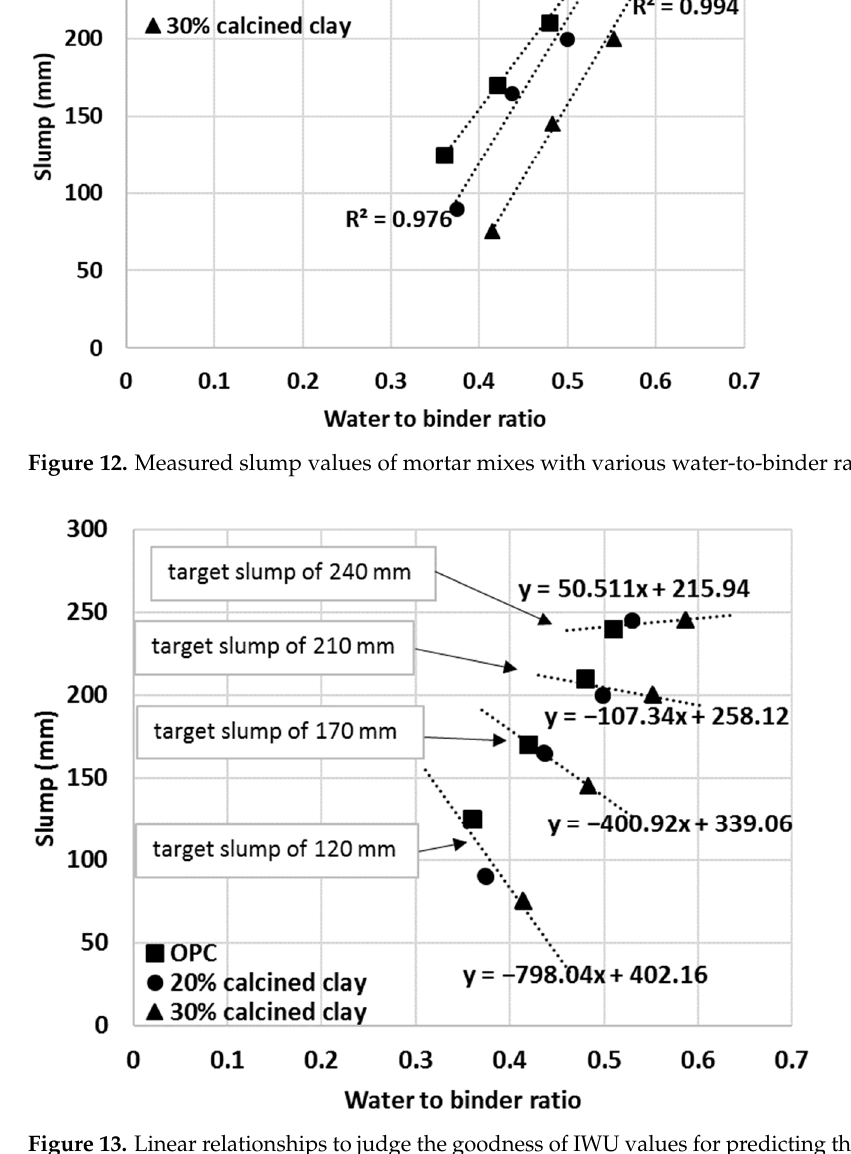
Figure 13. Linear relationships to judge the goodness of IWU values for predicting the water demand of various mortar mixes.